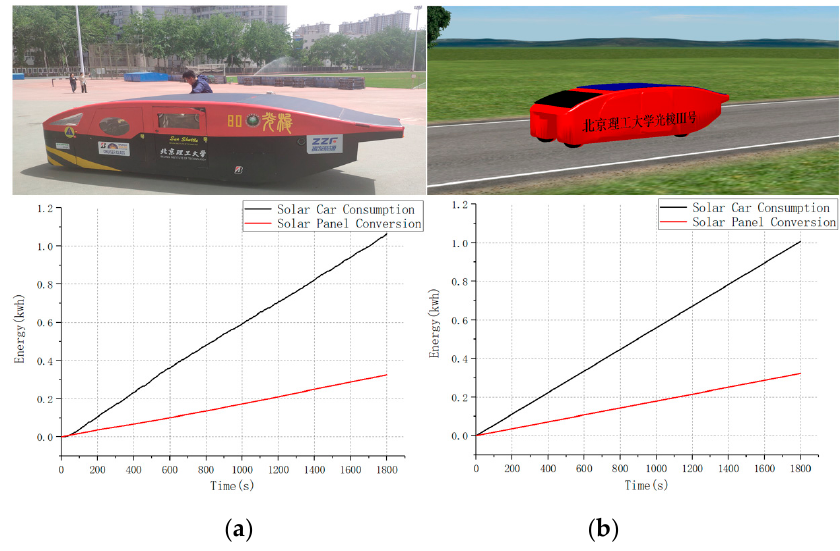
Figure 12. Comparison of test-simulation results: ( a ) Graph of test results; ( b ) Graph of simulation results.